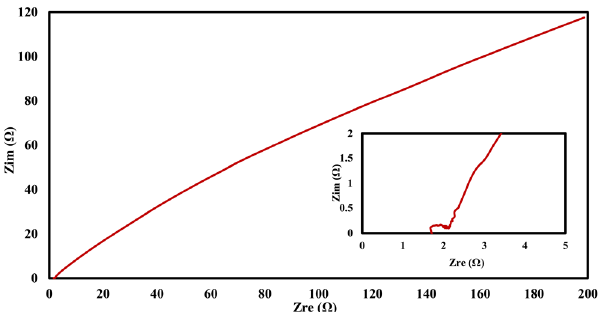
Figure 6. Nyquist plot of the supercapacitor electrode. The plot has been obtained from the electrochemical impedance spectroscopy (EIS) analysis results of electrode prepared from CF-6–1000, inset is the Nyquist plot at high frequency